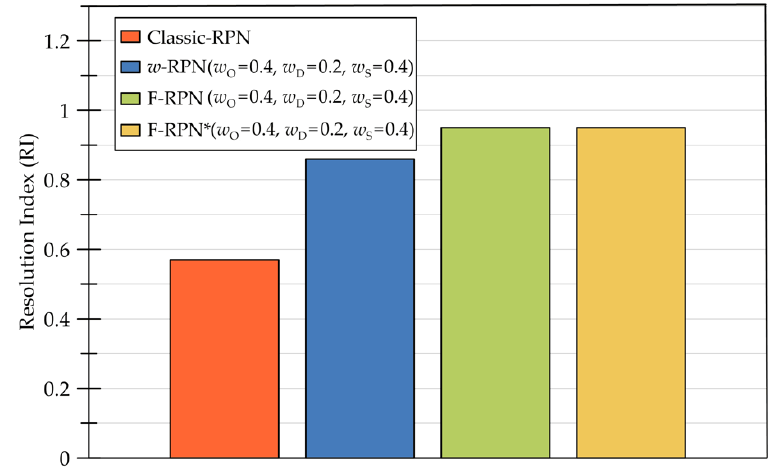
Figure 2. Comparison of results in terms of RI index.